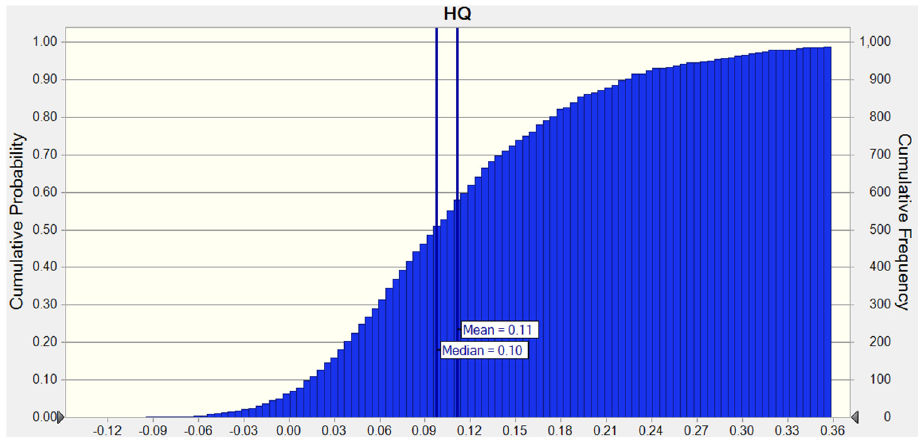
Figure 3. Cumulative probability distribution of the HQ of Pb exposure via soil ingestion pathway. The health risk was evaluated by a Monte Carlo simulation based on Crystal Ball soft for 10,000